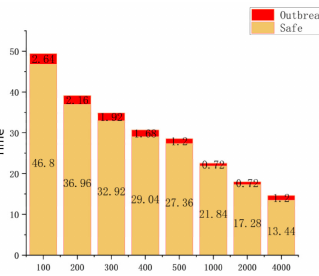
Figure 5. Virus outbreak nodes (virus propagation growth rate ≥ 50%. Red) and the safe time node that can effectively control the virus (virus transmission growth rate < 50%. Yellow). Table 4. Proportion of cargo volume in different boxes to total cargo volume before and after the virus outbreak.